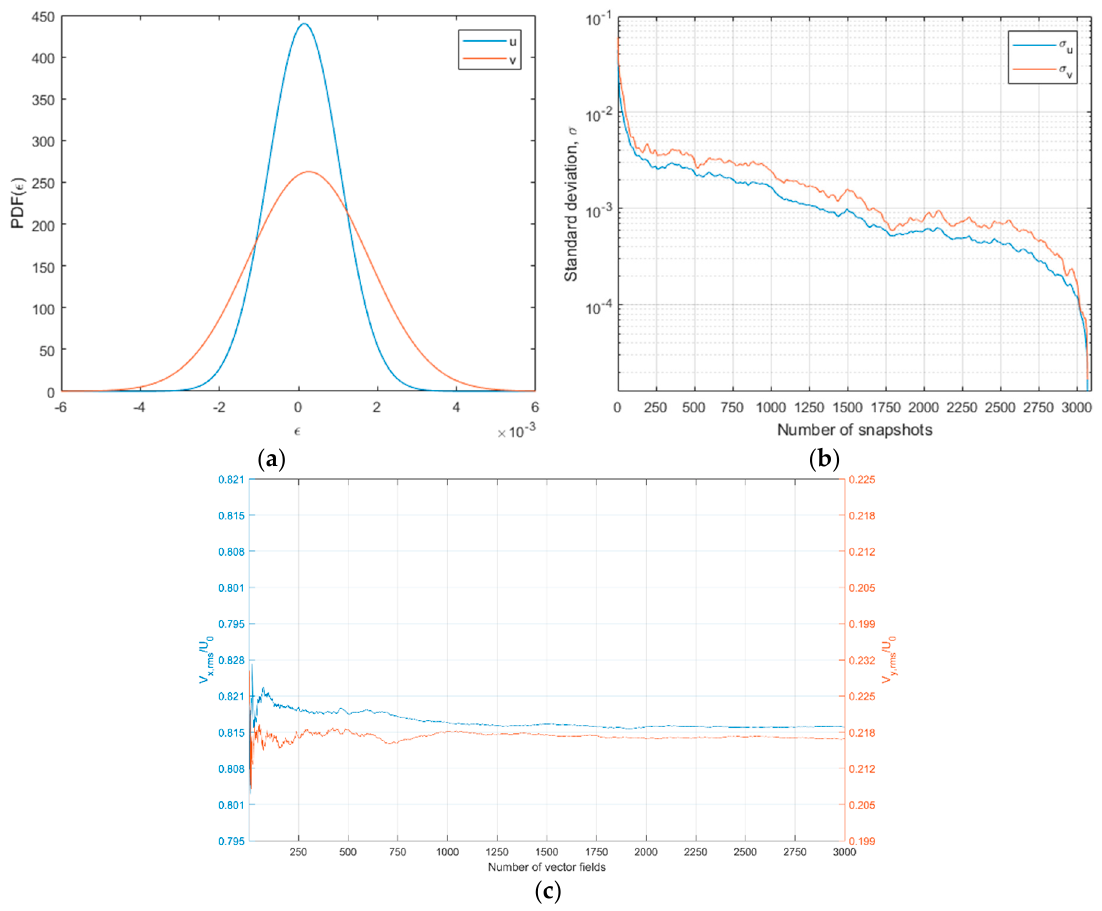
Figure 6. Demonstration of velocity convergence with number of samples. ( a ) PDF of error in u velocity, 𝜀 (cid:3048) for 1536 snapshots; ( b ) Trend of standard deviation of error, 𝜎 with increasing samples calculated from PDFs; ( c ) Field average velocity RMS convergence.